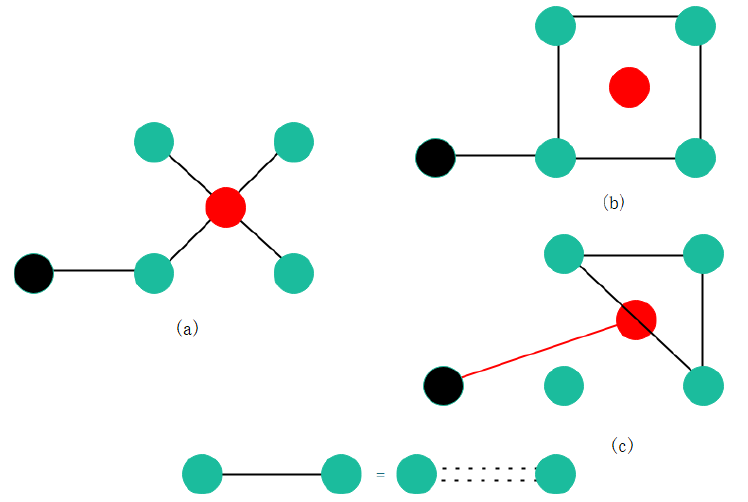
Figure 5. Different quantum preprocessing methods. ( a ) The central node (red circle) with a degree of 4 can perform entanglement swapping on 4 connected edges when doing quantum preprocessing. ( b ) The network structure obtained by doing q-swap on the central node, and the peripheral nodes (black circles) are not involved in the quantum preprocessing. ( c ) The central node operates on only 3 of its connected edges, and the last one is entangled and swapped with the connected edges of the peripheral nodes to obtain a new connected edge (red line). All nodes in the network are involved in the preprocessing process.